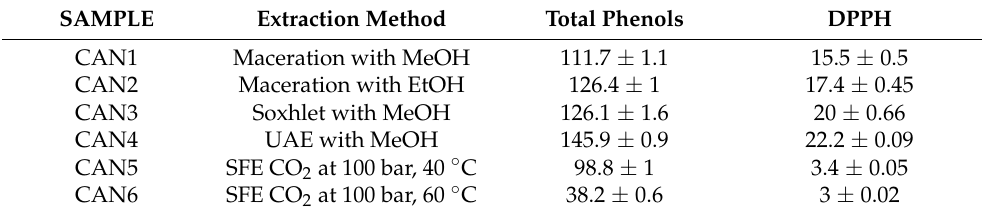
Table 2. Effect of different extraction methods on total polyphenol content and antioxidant activity of Cannabis . Total phenols data are expressed as equivalent of mg gallic acid/g of extract (mean, n = 3 ± SD). The antioxidant activity data are expressed as % of DPPH inhibition (mean, n = 3 ±